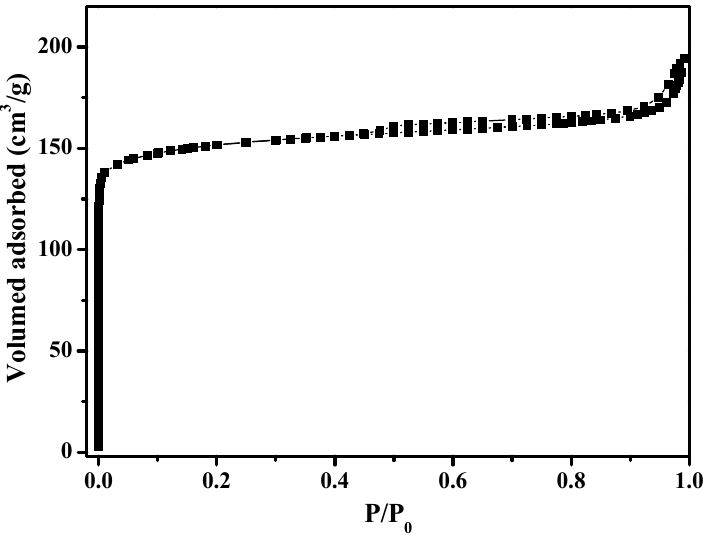
Figure 4. N 2 sorption isotherms of calcined S-Beta sample.